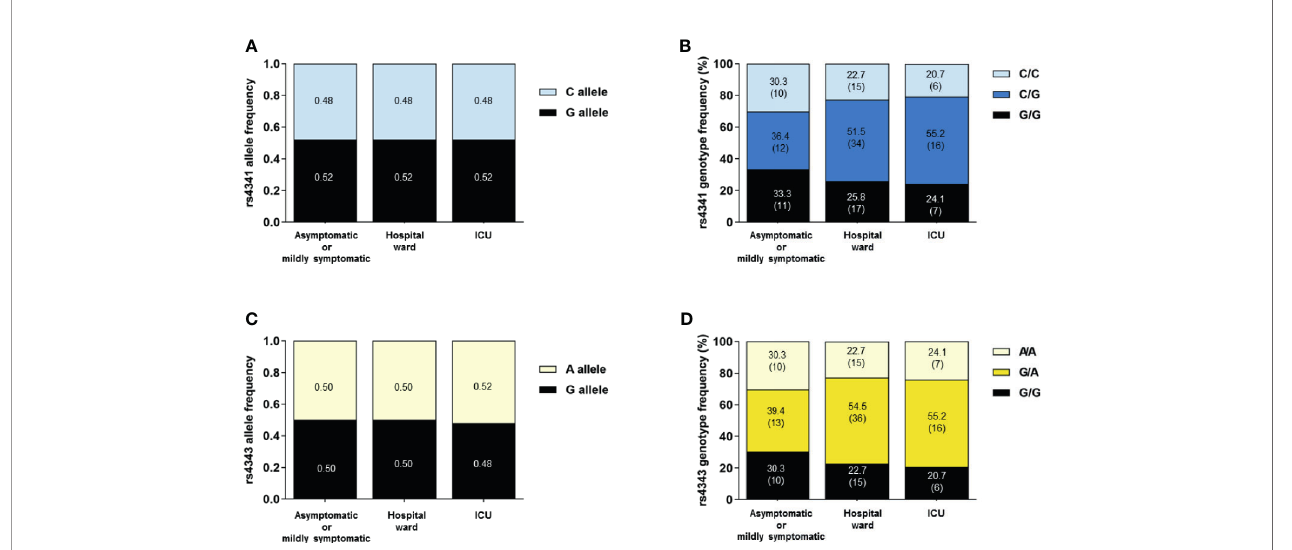
FIGURE 1 | Allele and genotype distribution of the rs4341 and rs4343 polymorphisms among SARS-CoV-2 infected patients. Allele frequencies of rs4341 (A) and rs4343 (C) polymorphisms. Data are presented as proportions. Genotype frequencies of rs4341 (B) and rs4343 (D) polymorphisms. Data are presented as percentages. The number of patients is indicated in brackets. All data were adjusted for age and